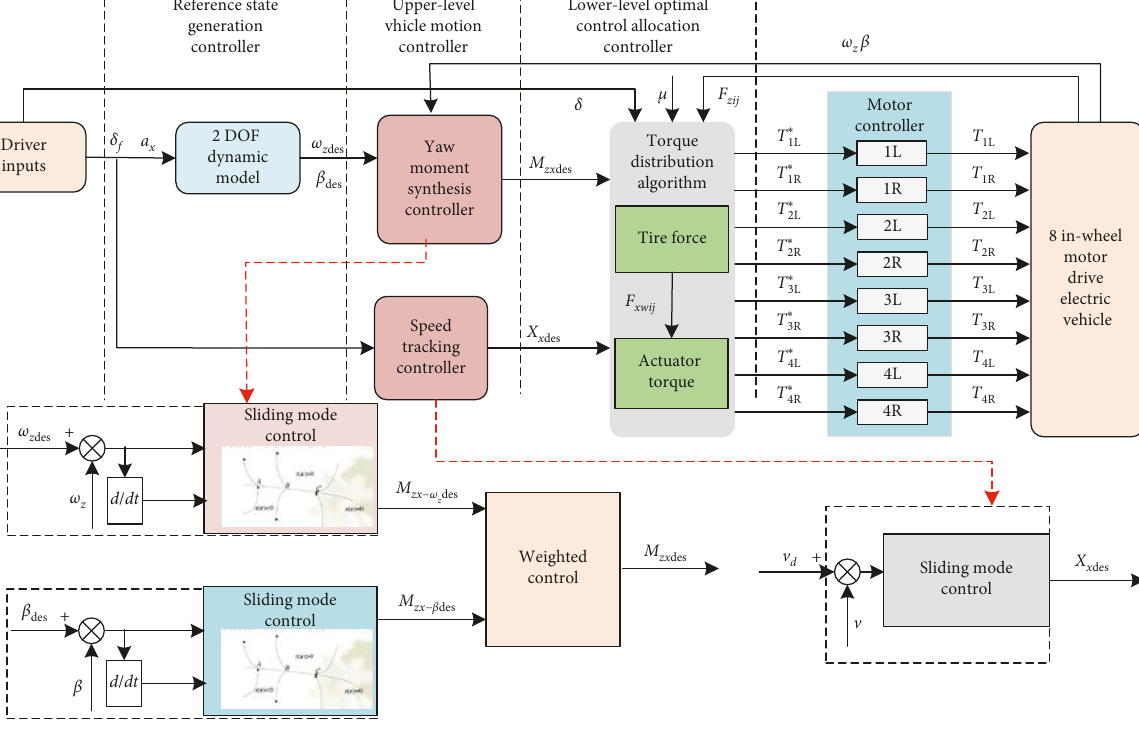
Figure 8: Control structure for